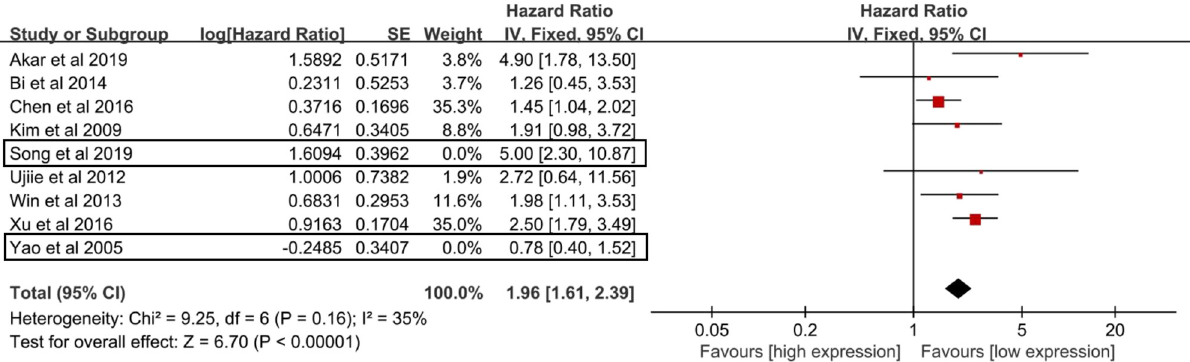
Figure 4: Meta - analysis for the association between NNMT expression and OS after the removal of the studies of Song et al. and Yao et al. also indicating that high NNMT expression was signi fi cantly associated with worse OS compared to low NNMT expression in cancer patients.